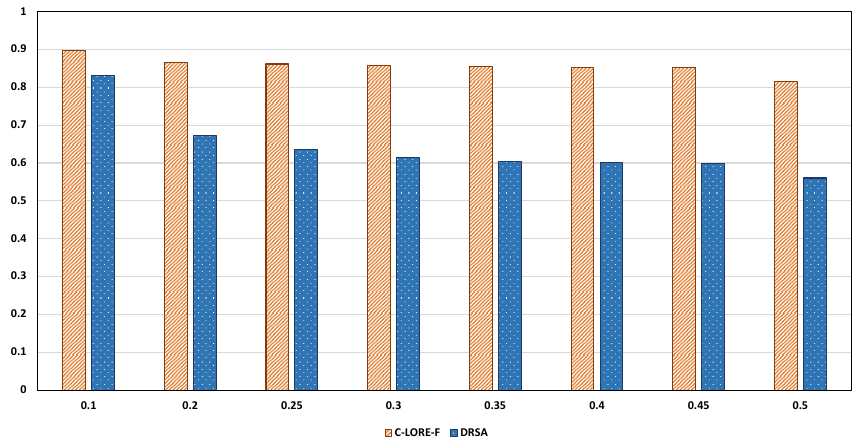
Figure 4. Degree of locality vs globality of the explanation models. The x -axis represents the thresholds and the y -axis represents the